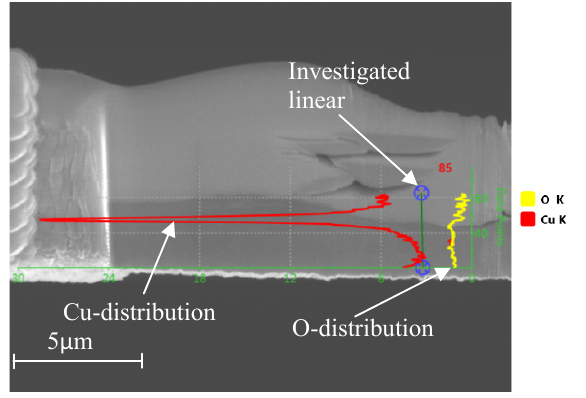
Figure 8. SEM Linear element analysis of the machined lamella from the surface with the 0.5 wt% oil sample